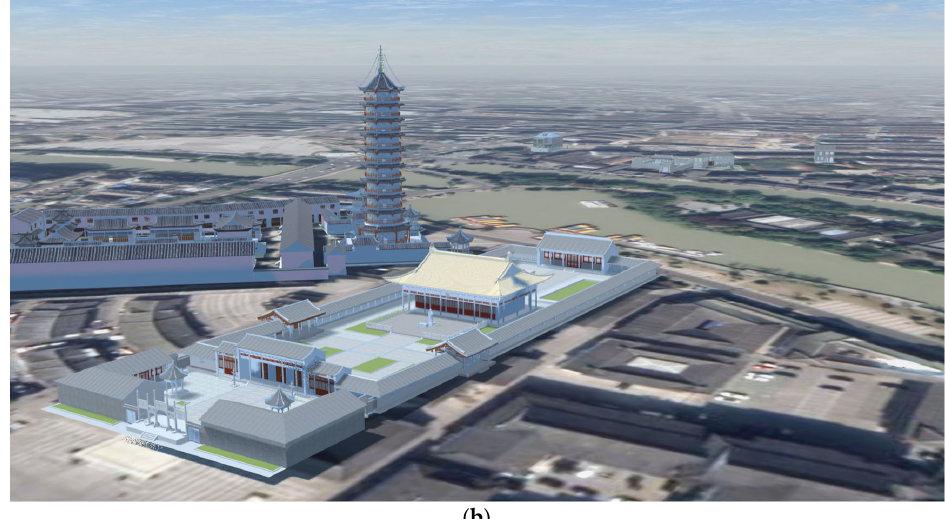
Figure 6. Two-three dimensional fusion scene realization. ( a ) Ciyun Temple, ( b ) Confucious Temple.